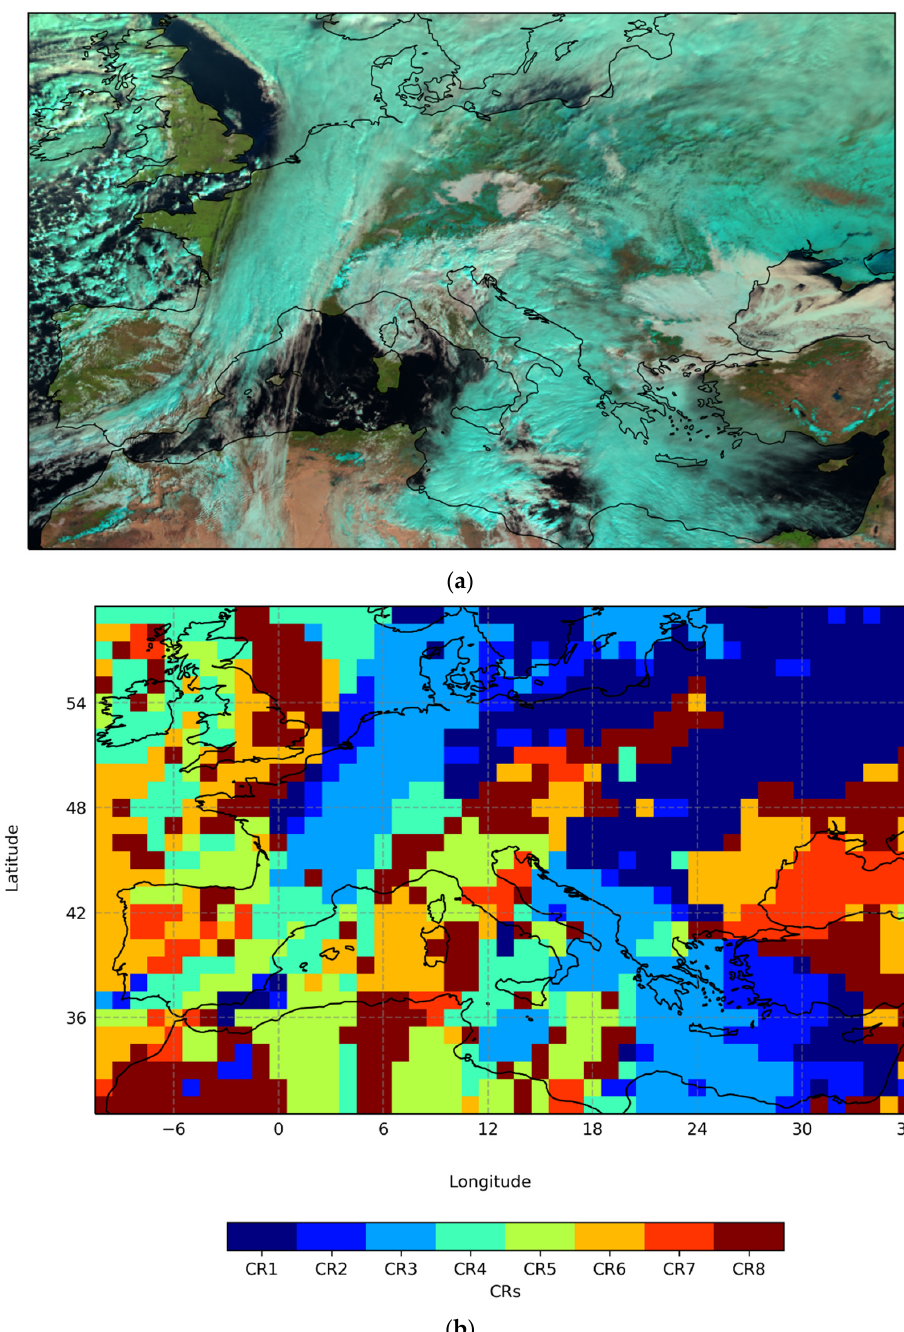
Figure 3. Illustration of the cloud regime classification from CRAAS for 1 February 2014 at 10.30 UTC. ( a ) SEVIRI Natural Color RGB image over Europe, composed using the 0.6, 0.8 and 1.6 micron channels; ( b ) color-coded map of the CRAAS cloud regime classification.